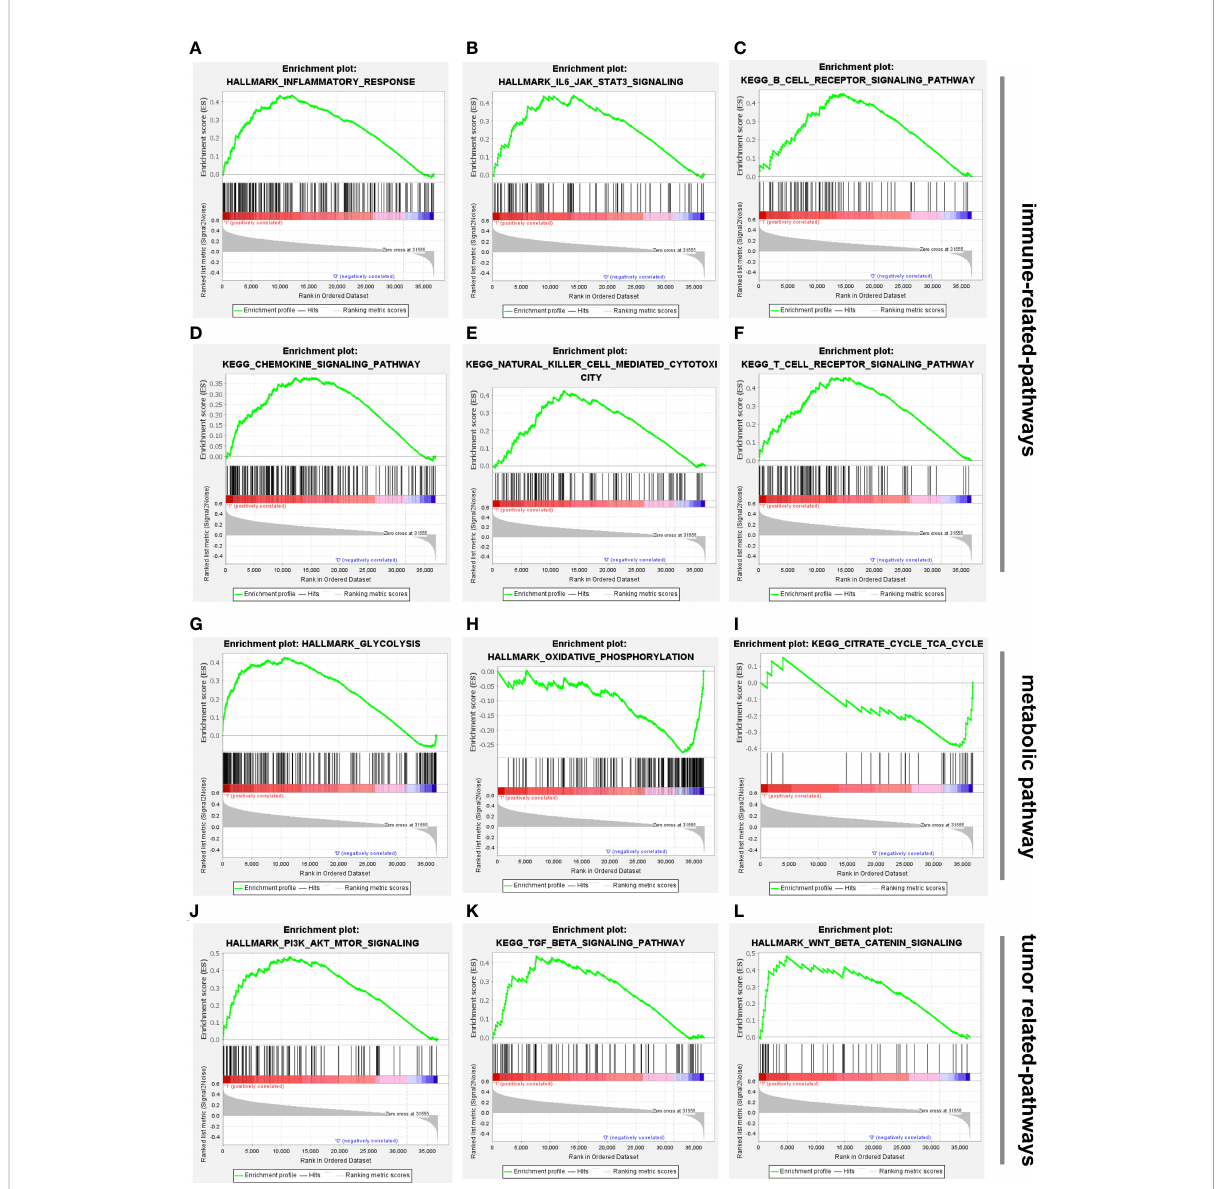
FIGURE 7 Biological functional and pathway enrichment analysis of high-risk group and low-risk group based on the cuproptosis-associated lncRNA signature via GSEA analysis. (A-F) GSEA showing signi fi cant enrichment of immune-related pathways in the high-risk HCC patients, including in fl ammatory response, IL6/JAK/STAT3 signaling, B cell receptor signaling pathway, chemokine signaling pathway, natural killer cell mediated- cytotoxicity and T cell receptor signaling pathway. (G-I) Glycolysis was mainly enriched in the high-risk group while oxidative phosphorylation and citrate cycle TCA cycle were related to low-risk group. (J-L) GSEA showing signi fi cant enrichment of tumor-related pathways in the high- risk HCC patients, including PI3K/AKT/mTOR, TGF- b signaling and wnt/ b /cantenin pathways. lncRNAs, long noncoding RNAs; HCC, hepatocellular carcinoma; GSEA, gene enrichment